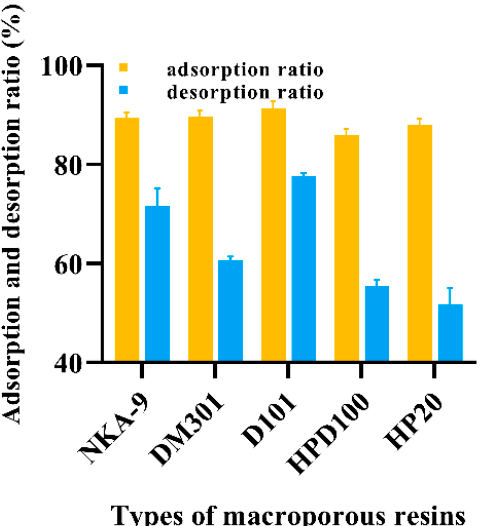
Figure 4. Adsorption and desorption rates of different kinds of macroporous resins.